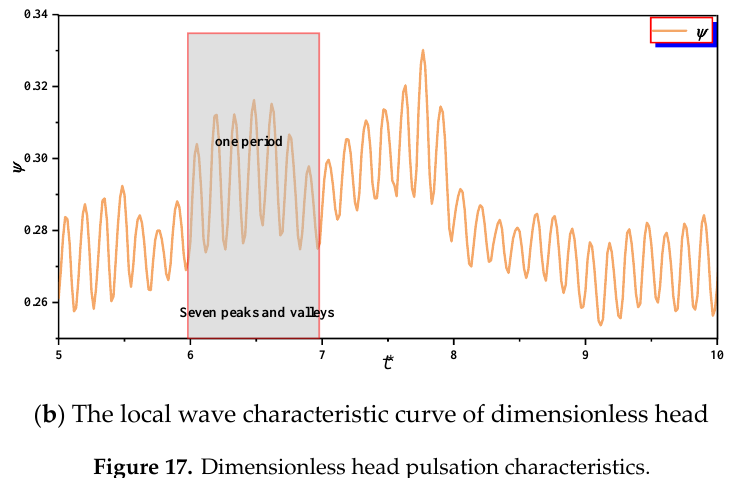
Figure 17. Dimensionless head pulsation characteristics. Processes 2020 , 8 , 278